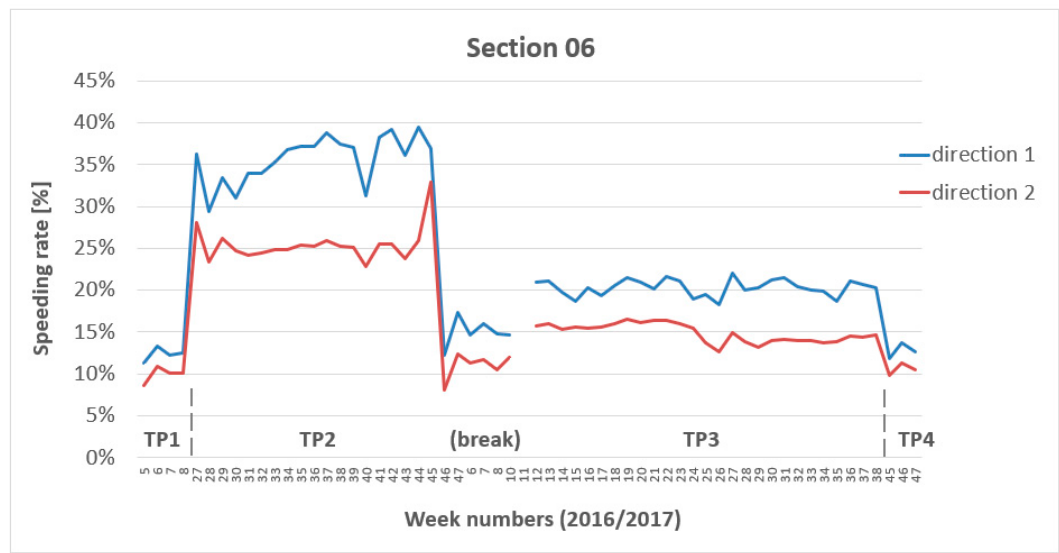
Figure 6. Example graph of speeding rates in time (TP denotes analysed time periods).